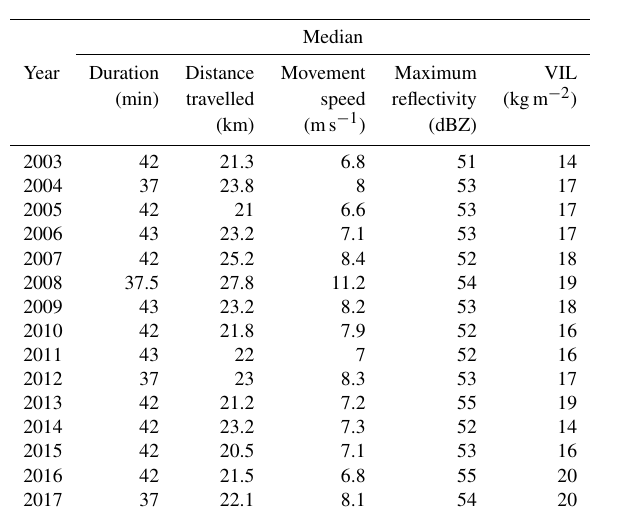
Table 1. Characteristics of convective storms in the Prut River basin, for different years of the 2003–2017 period.